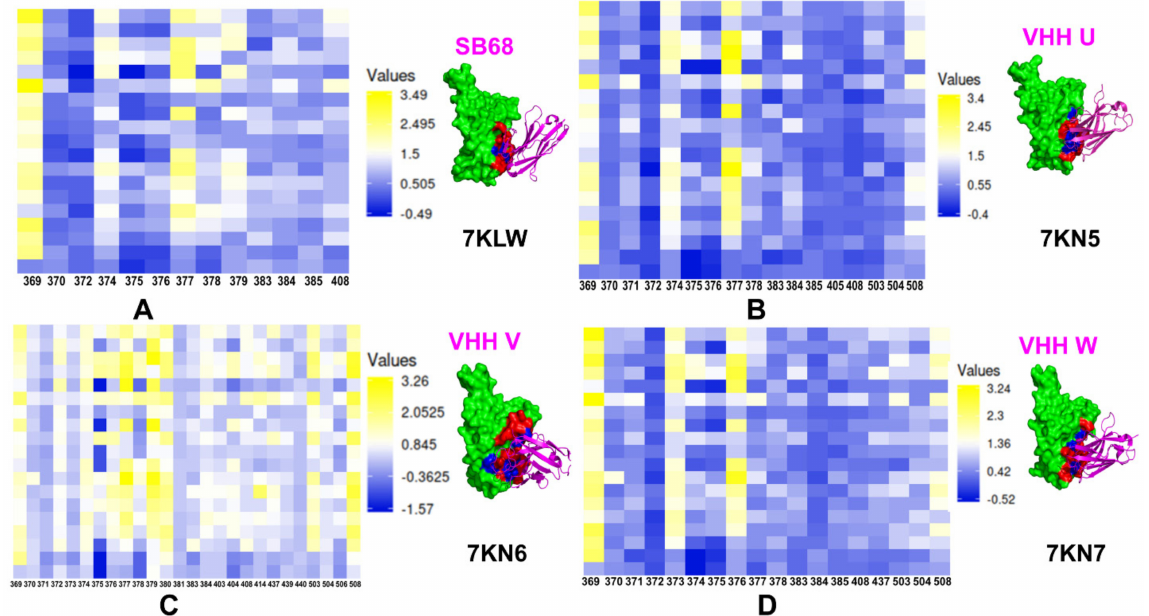
Figure 6. Mutational profiling of the SARS-CoV-2 S binding with class I nanobodies. ( A ) The mu- tational scanning heatmap and structural map for the SARS-CoV-2 S complex with Sb68 nanobody. The S-RBD is shown in green surface. The epitope residues are shown in red and the binding energy hotspots from are shown in blue surface. ( B ) The mutational scanning heatmap and structural map for the SARS-CoV-2 S complex with VHH U nanobody. The annotations for the epitope residues and the binding energy hotspots are as in panels A,B. ( C ) The mutational scanning heatmap and structural map for the SARS-CoV-2 S complex with VHH V nanobody. ( D ) The mutational scanning heatmap and structural map for the SARS-CoV-2 S complex with VHH W nanobody. The heatmaps show the computed binding free energy changes for 19 single mutations on the binding epitope sites. The squares on the heatmap are colored using a 3-colored scale from blue to yellow with yellow indicating the largest unfavorable effect on